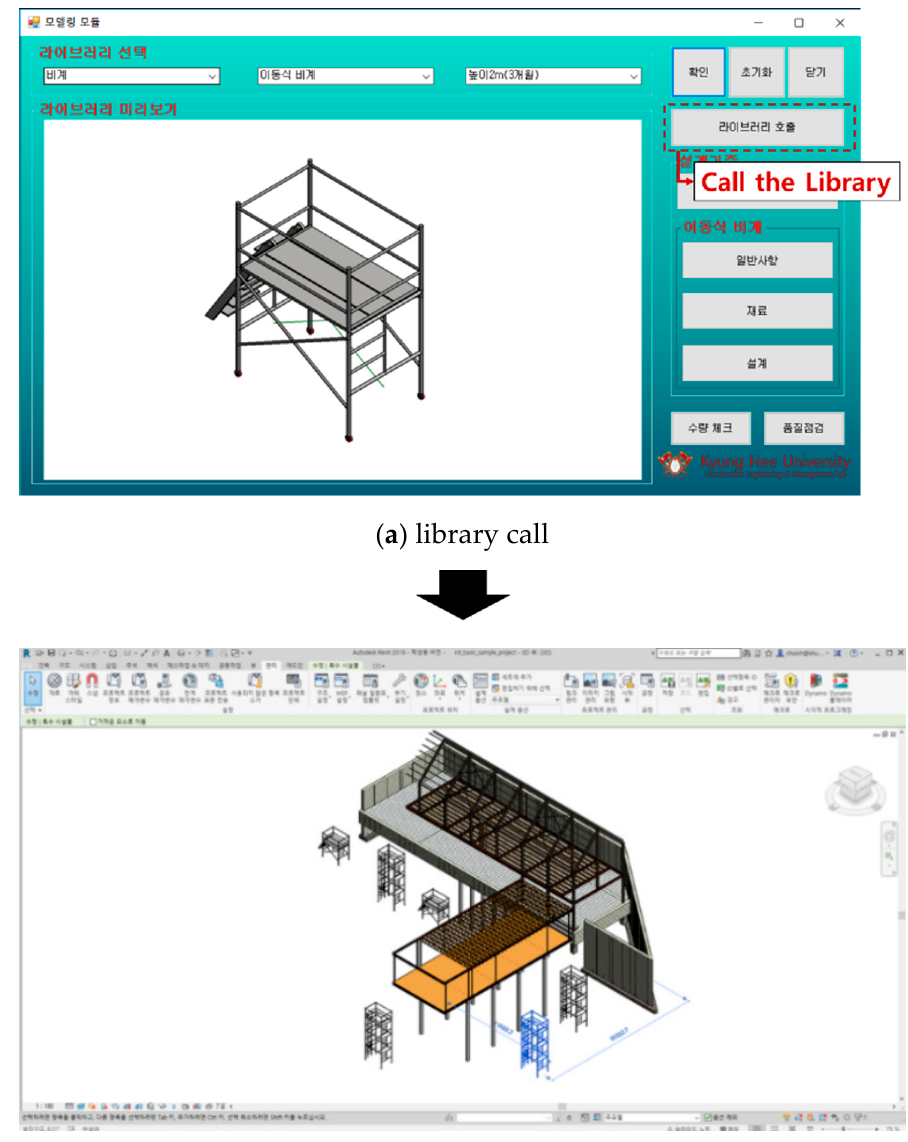
Figure 6. BIM modeling module—library call.